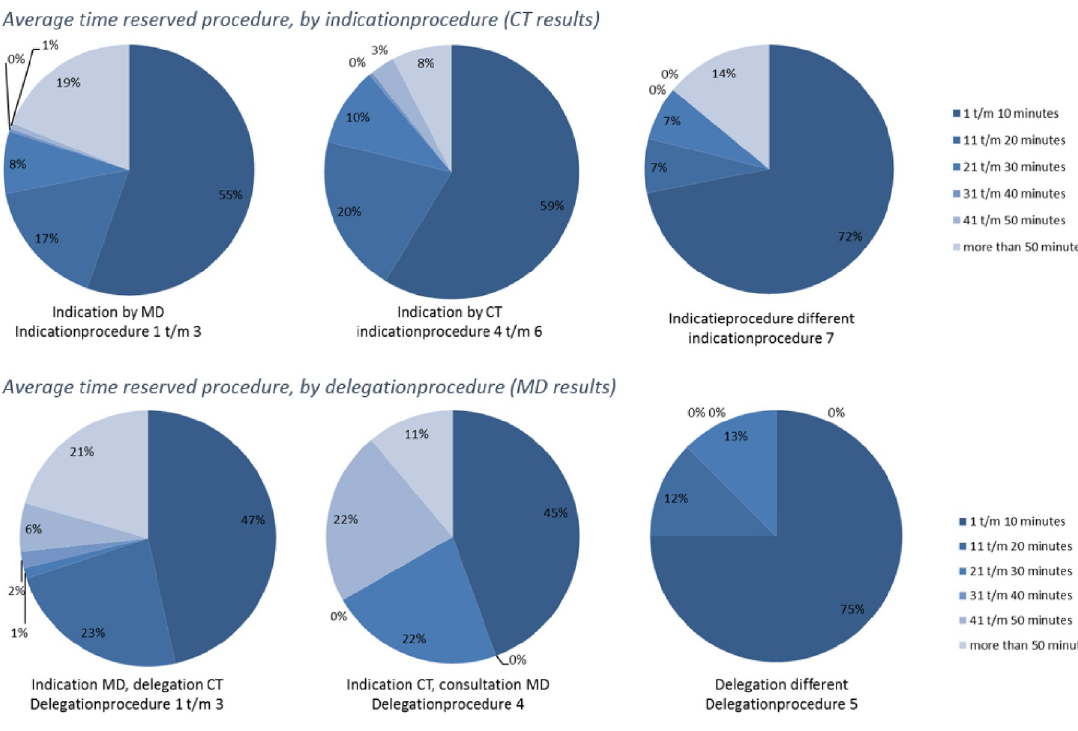
Fig 3. Overview results reserved procedures